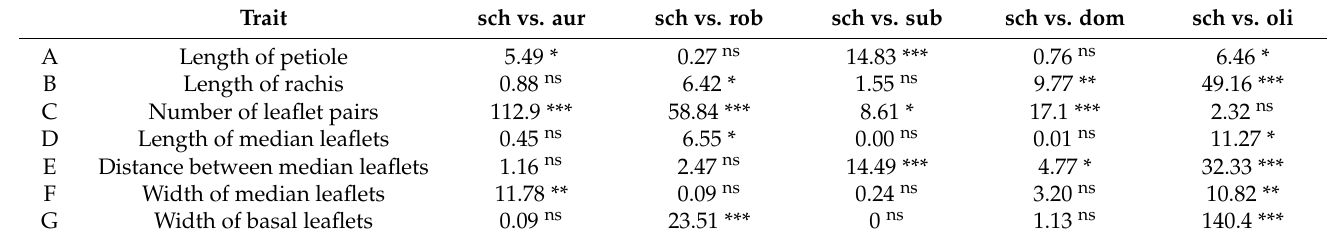
The multivariate analyses were clearer at distinguishing the overall morphometric